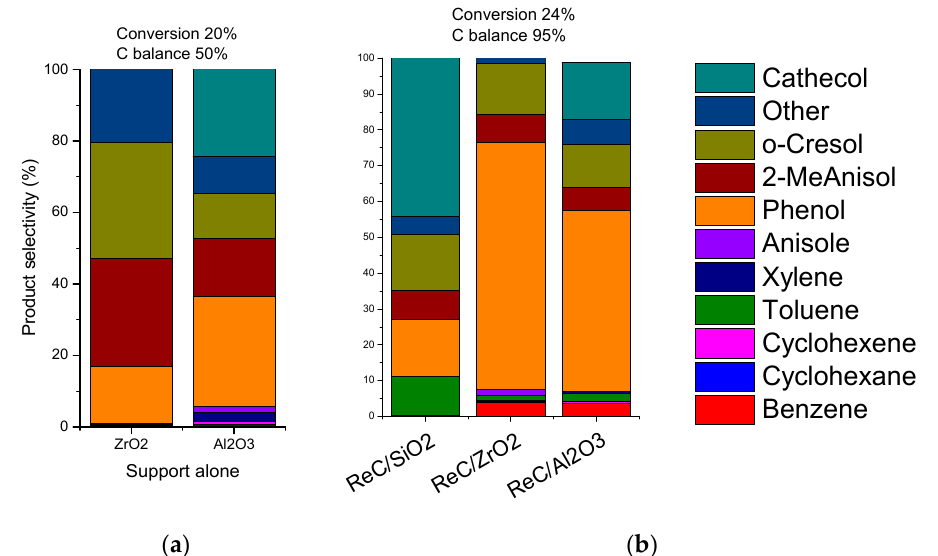
Figure 8. Comparison of the product selectivities obtained at 20–24% of guaiacol conversion and the respective carbon balances over the bare supports ( a ) and the catalysts ( b ). Reaction conditions: 200 mg catalyst, 350 °C, 5.0 MPa H 2 .